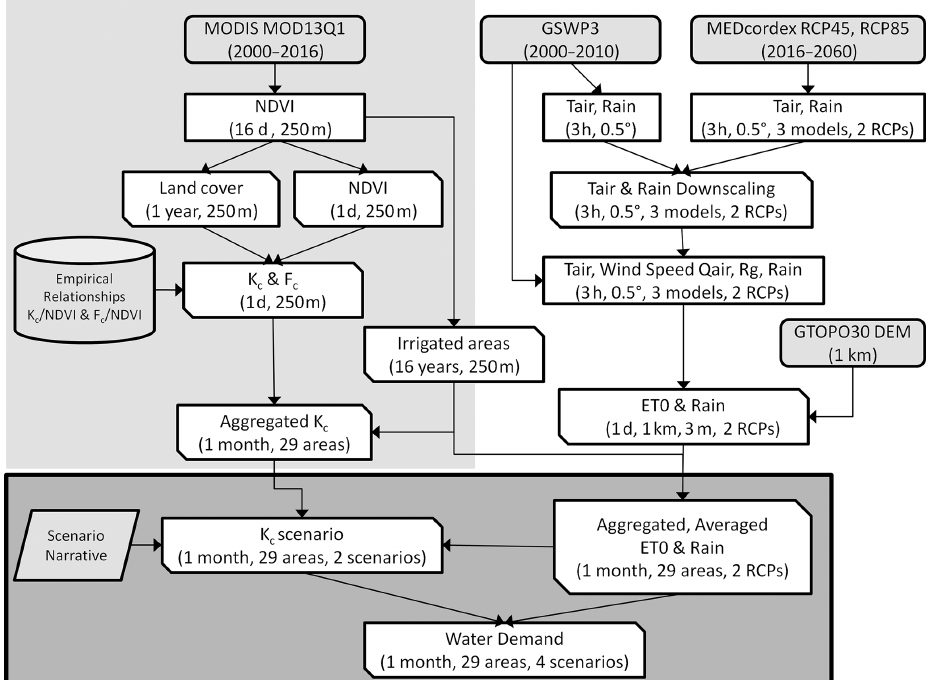
Figure 2. Processing steps flowchart. The light gray area of the flowchart was presented in Le Page et al. (2012). The calculations on K c are performed on 29 irrigated areas. The input data are indicated in gray boxes. Variable extraction is indicated by a square box. Processing steps (and their results) are indicated by boxes with beveled corners. The indications between parentheses show the temporal, spatial, and scenario resolutions. The scenario generation described in this article is indicated in dark gray.